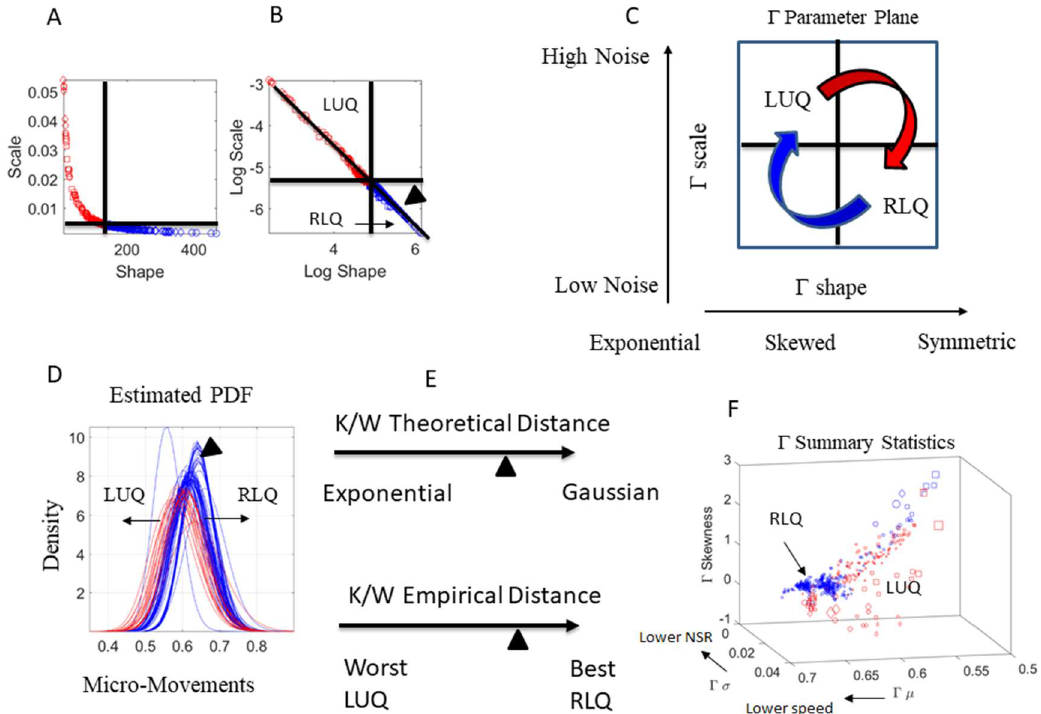
Figure 5. General characterization of stochastic signatures and empirically-derived criteria for targeted performance. ( A ) The Gamma parameter plane spanned by the shape and scale dimensions. Each point localizes the signatures of the person’s performance for a given segment of the routine. The quadrants defining regions of interest to track performance are defined by the median of the shape and scale parameters (dynamically changing over the routines) and empirically defining the good region by the right lower quadrant (RLQ) with probability distributions tending to the Gaussian (symmetric) with a low noise to signal ratio (low scale value). The left upper quadrant (LUQ) instead denotes regions of high randomness (towards 1, the shape value of the memoryless Exponential distribution) and with a high noise to signal ratio. ( B ) The log-log Gamma Parameter plane yields a power low-like relation of the MM data. The arrow head represents one PDF in the RLQ, localizing it in in ( D – F ). ( C ) Schematics representing the different stochastic states of the data, as they evolve over time. ( D ) Empirically estimated Probability Density Functions (PDFs) from the data in ( A , B ). ( E ) Different distance criteria to ascertain similarities and differences between points in the probability space of interest. One criterium uses theoretical limiting points (Exponential with high noise vs. Gaussian with low noise), while the other uses empirically-estimated limiting points, derived from extrema of the entire data set. ( F ) The Gamma summary statistics providing the empirically-derived moments of the distributions fit. Regions of interest are color-coded as in the previous panels. Scale from 0–1 corresponds to speed MM